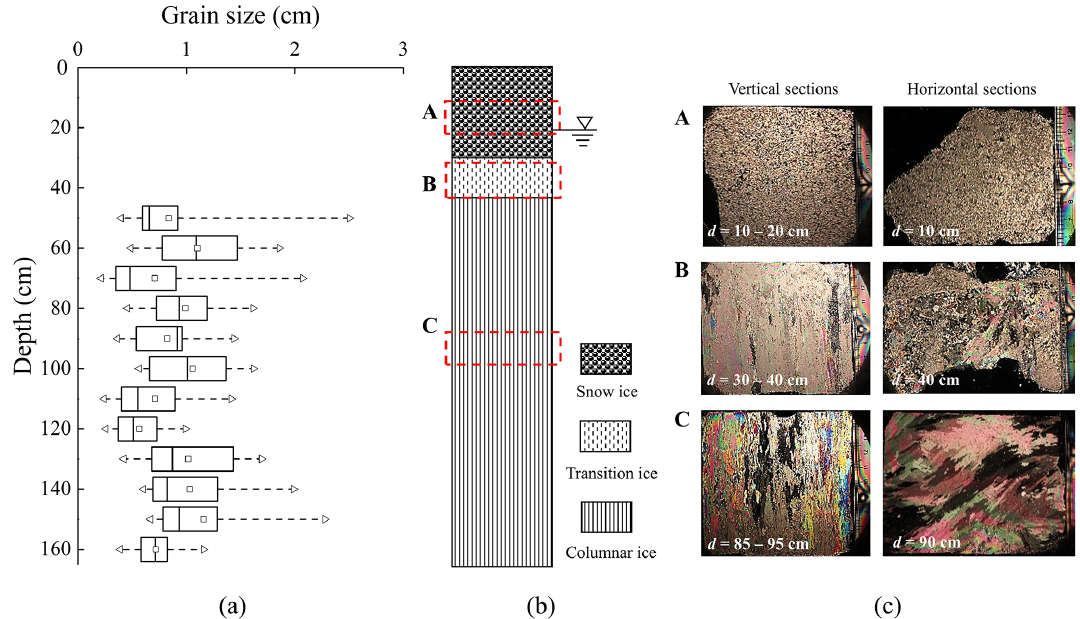
Figure 4. (a) Box chart of grain sizes along ice depth, (b) the stratigraphy diagram of the ice crystal structure profile, and (c) typical pictures of grain types. The grain sizes in the top 40cm of the ice sheet were too small to be identified clearly in (a) and d represents ice depth in (c) . The freeboard of ice is approximately